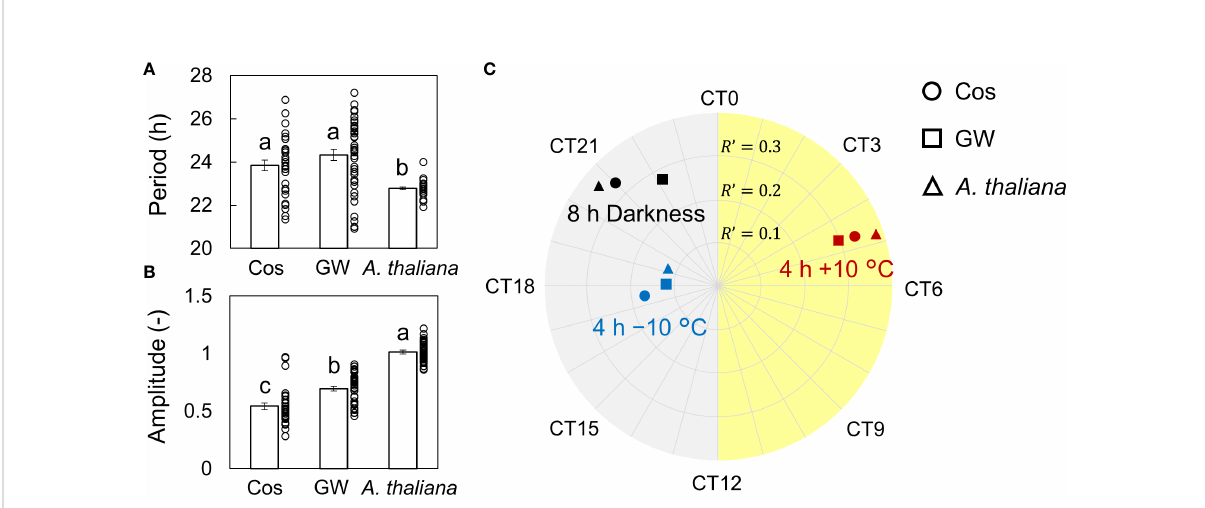
FIGURE 2 Periods, amplitude, and singularity response (SR) to dark and temperature stimuli of Lactuca sativa L. during an experiment to investigate the effect of time lags in light: dark and temperature cycles during cultivation. (A) Natural periods of leaf lettuce (cv. Cos and GW), and Arabidopsis thaliana (mean ± SEM; n = 31 individuals in Cos and A thaliana , and 40 in GW). (B) Amplitude of Cos and GW and A thaliana (mean ± SEM; n = 31 in Cos and A thaliana , and 40 in GW). The circles indicate the individual data points. Two values which have no common letter show signi fi cant differences (Tukey-Kramer test, p < 0.05). (C) SR to 8-h darkness and 4 h of ±10°C stimuli of Cos and GW and A thaliana . R ’ is described as the distance from the center point. CT is circadian time, and CT2 is de fi ned as the peak time of the bioluminescence of AtCCA1 :: LUC